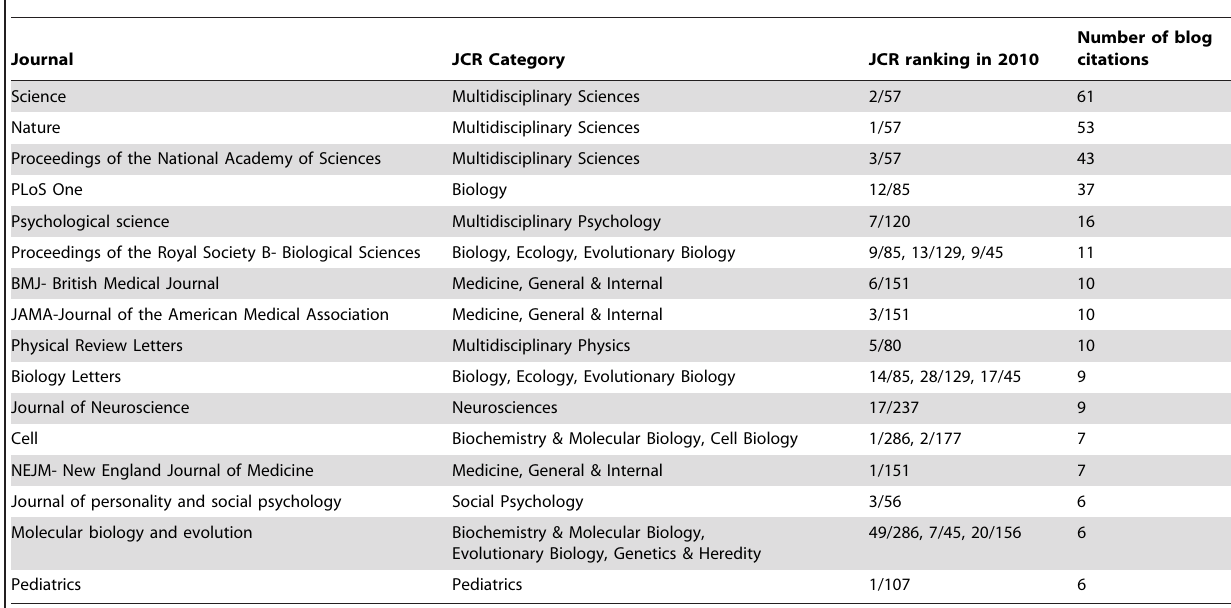
Table 5. Most cited journals according to number of blog citations, JCR category and JCR ranking in 2010.